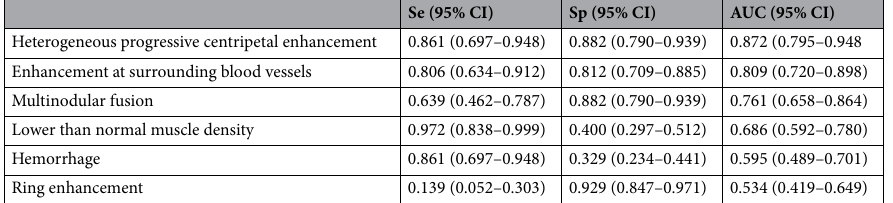
Table 3. Sensitivity, specificity, AUC and 95% CI of the single characteristic features. Se sensitivity, Sp specificity, CI confidence interval, AUC area under the curve.